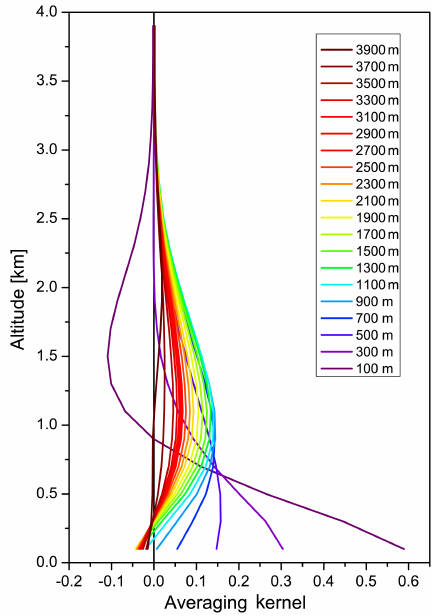
Figure 3. Example for aerosol extinction averaging kernels from the Heidelberg retrieval algorithm for 2 July 2009,